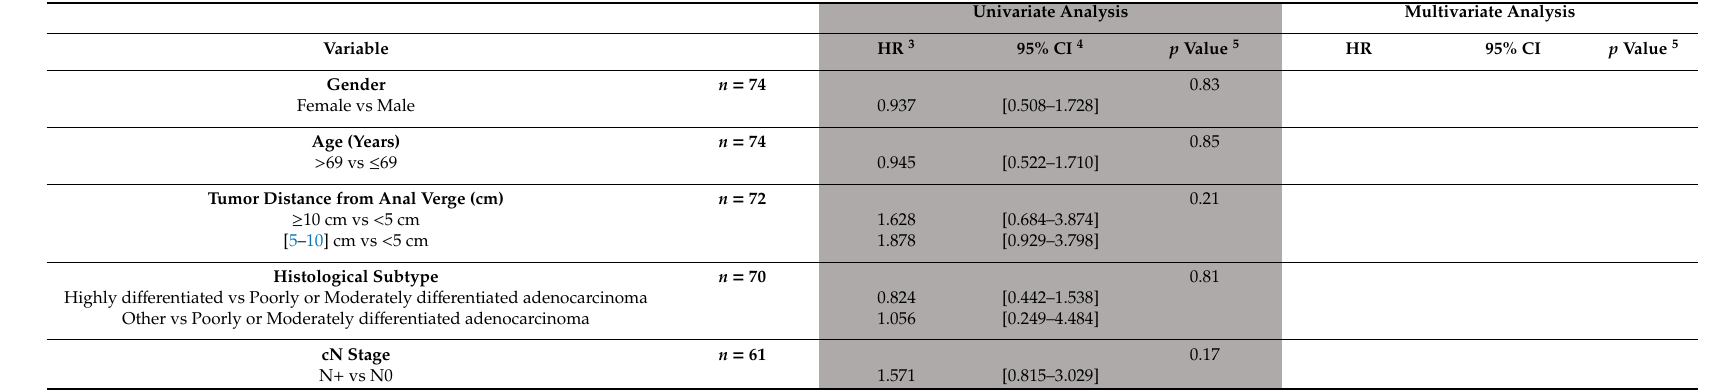
Table 5. Relation between clinical variables at baseline and after treatment and progression-free